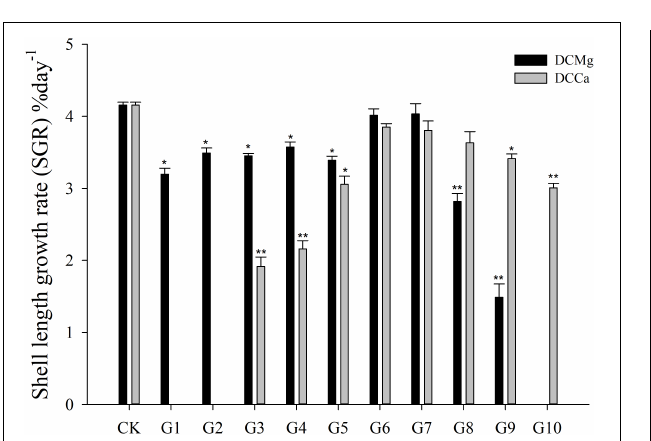
FIGURE 4 | Relative NKA activity of JSCs under long-term stress with different Ca 2 + and Mg 2 + concentrations. Results show NKA activity at 30-days normalized to the 0-day. Bars (mean ± SE, n = 3) with an asterisk denote a significant difference ( ∗ P < 0.05, ∗∗ P < 0.001) between the test groups (G1–G10) and